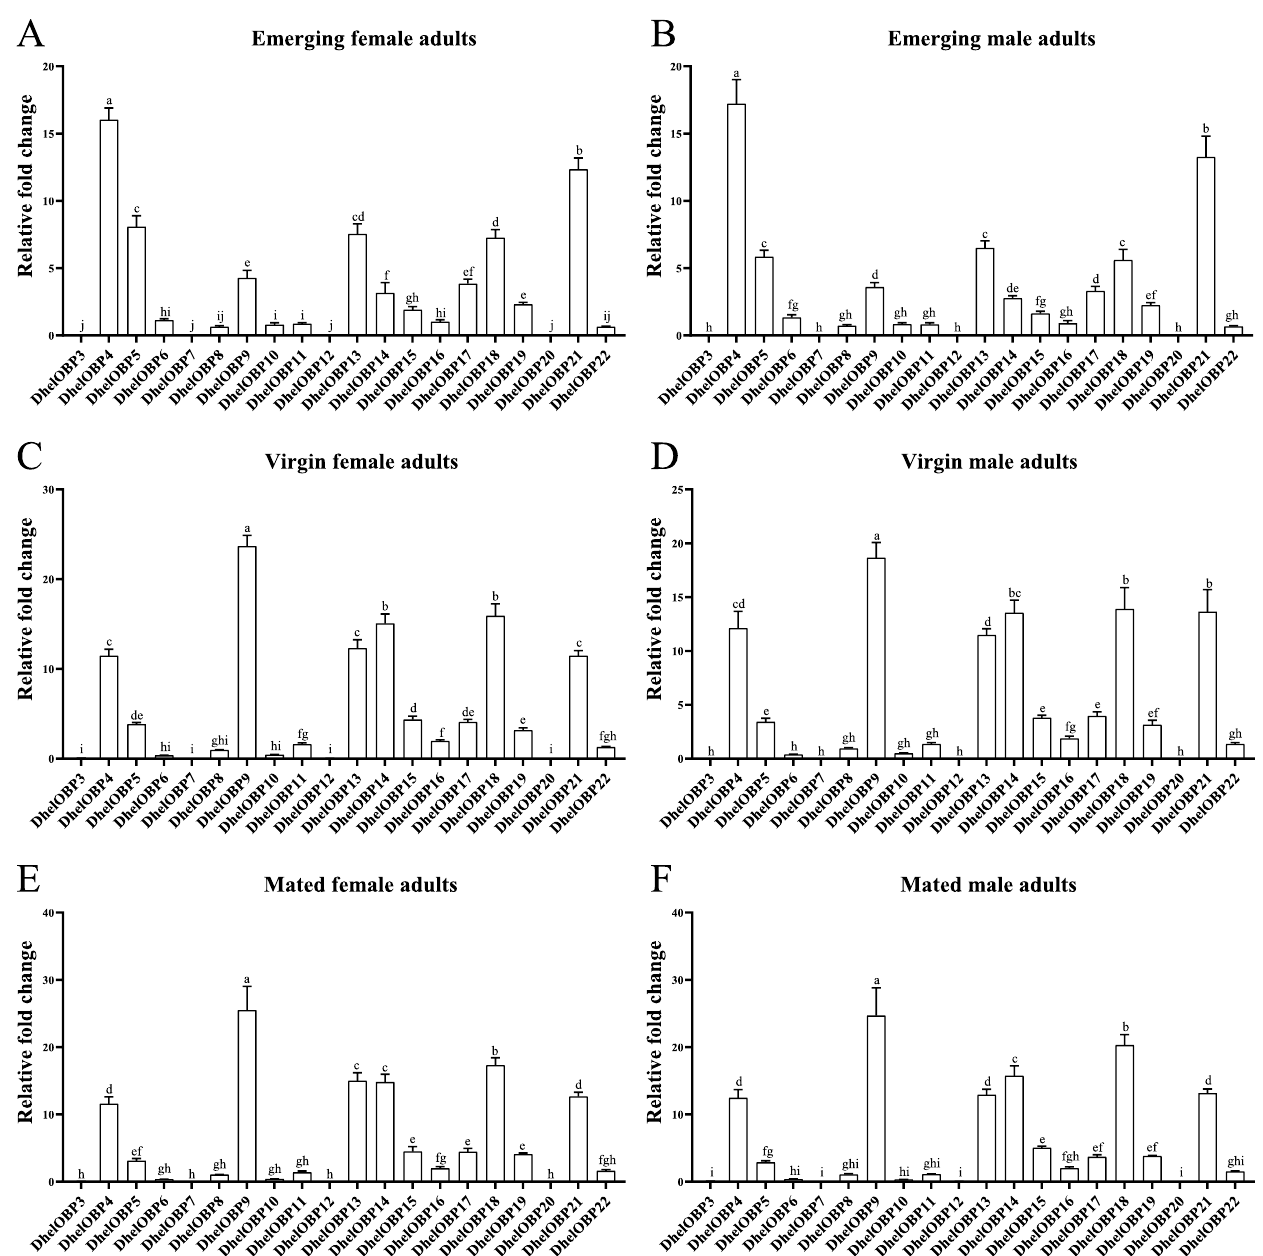
Figure 4. Comparison of transcript levels of different DhelOBPs in antennae for female and male adults. ( A – F) are the expression levels of DhelOBPs in adults antennae at different physiological states (emerging, virgin, and mated). The results were analyzed using one-way ANOVA with Tukey’s HSD post hoc test. Same letters, no significant difference; Different letters, significant difference.